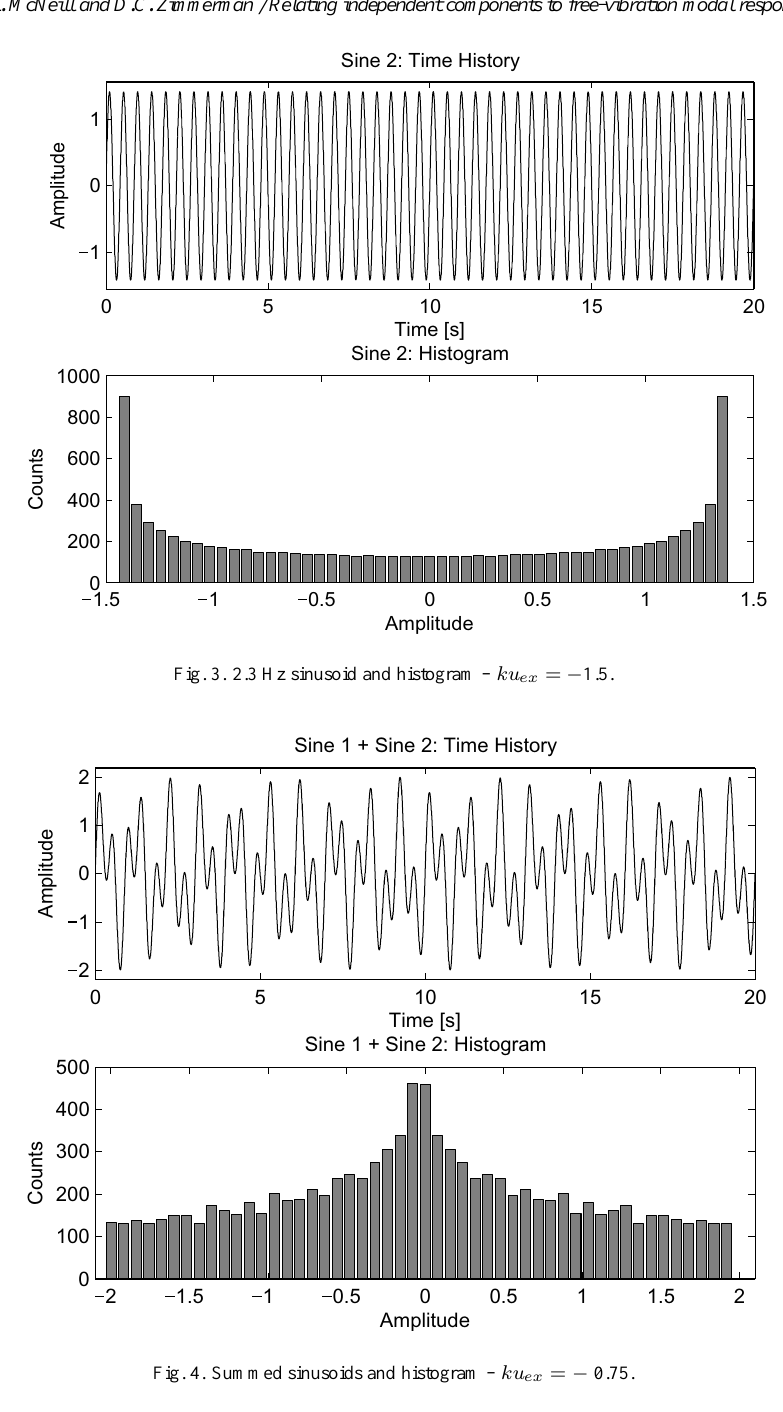
Fig. 4. Summed sinusoids and histogram – ku ex = −